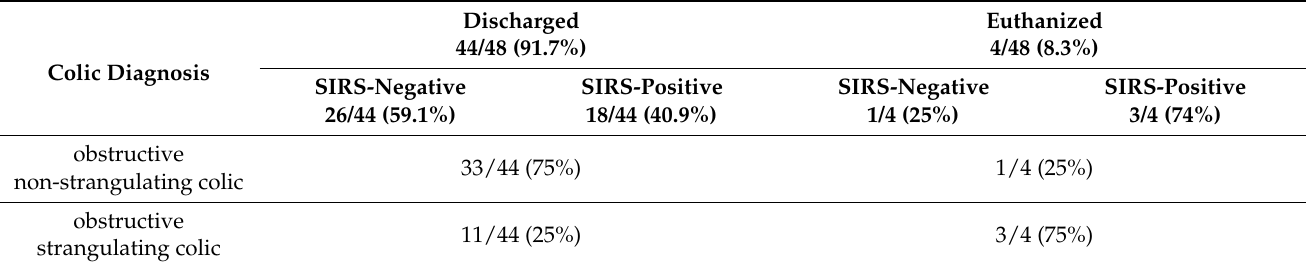
Table 2. Diagnosis (grouped as non-strangulating or strangulating colic) and SIRS status (positive or negative) of the discharged or euthanized